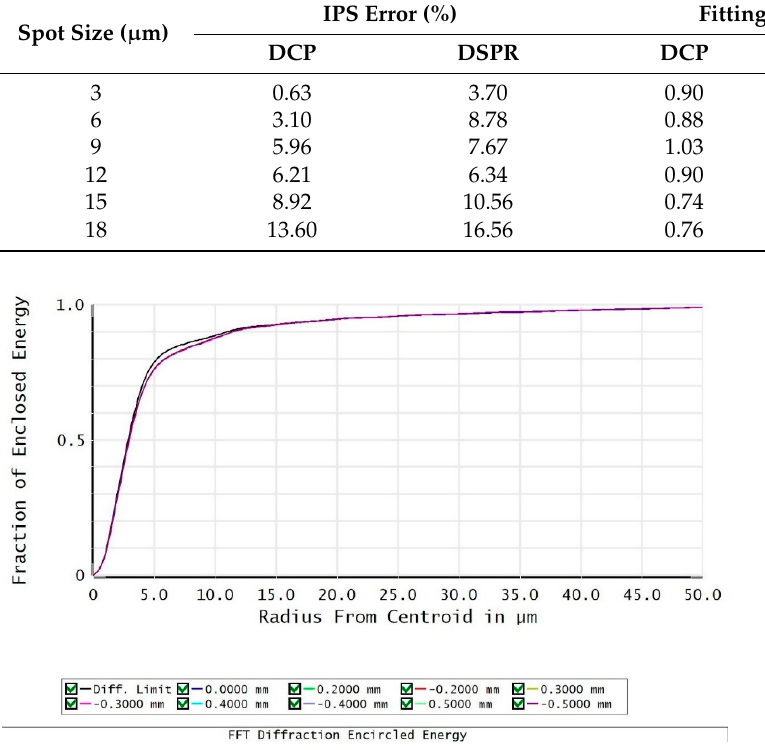
Figure 6. Fraction of enclosed energy of optical system using ZEMAX simulation.